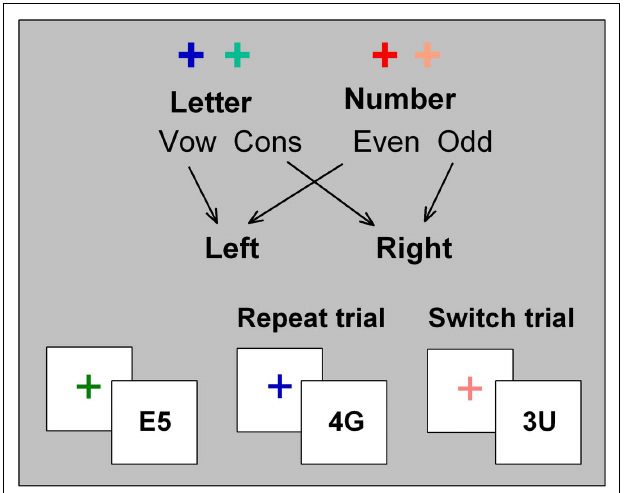
FIGURE 1 | Cued-trials task-switching